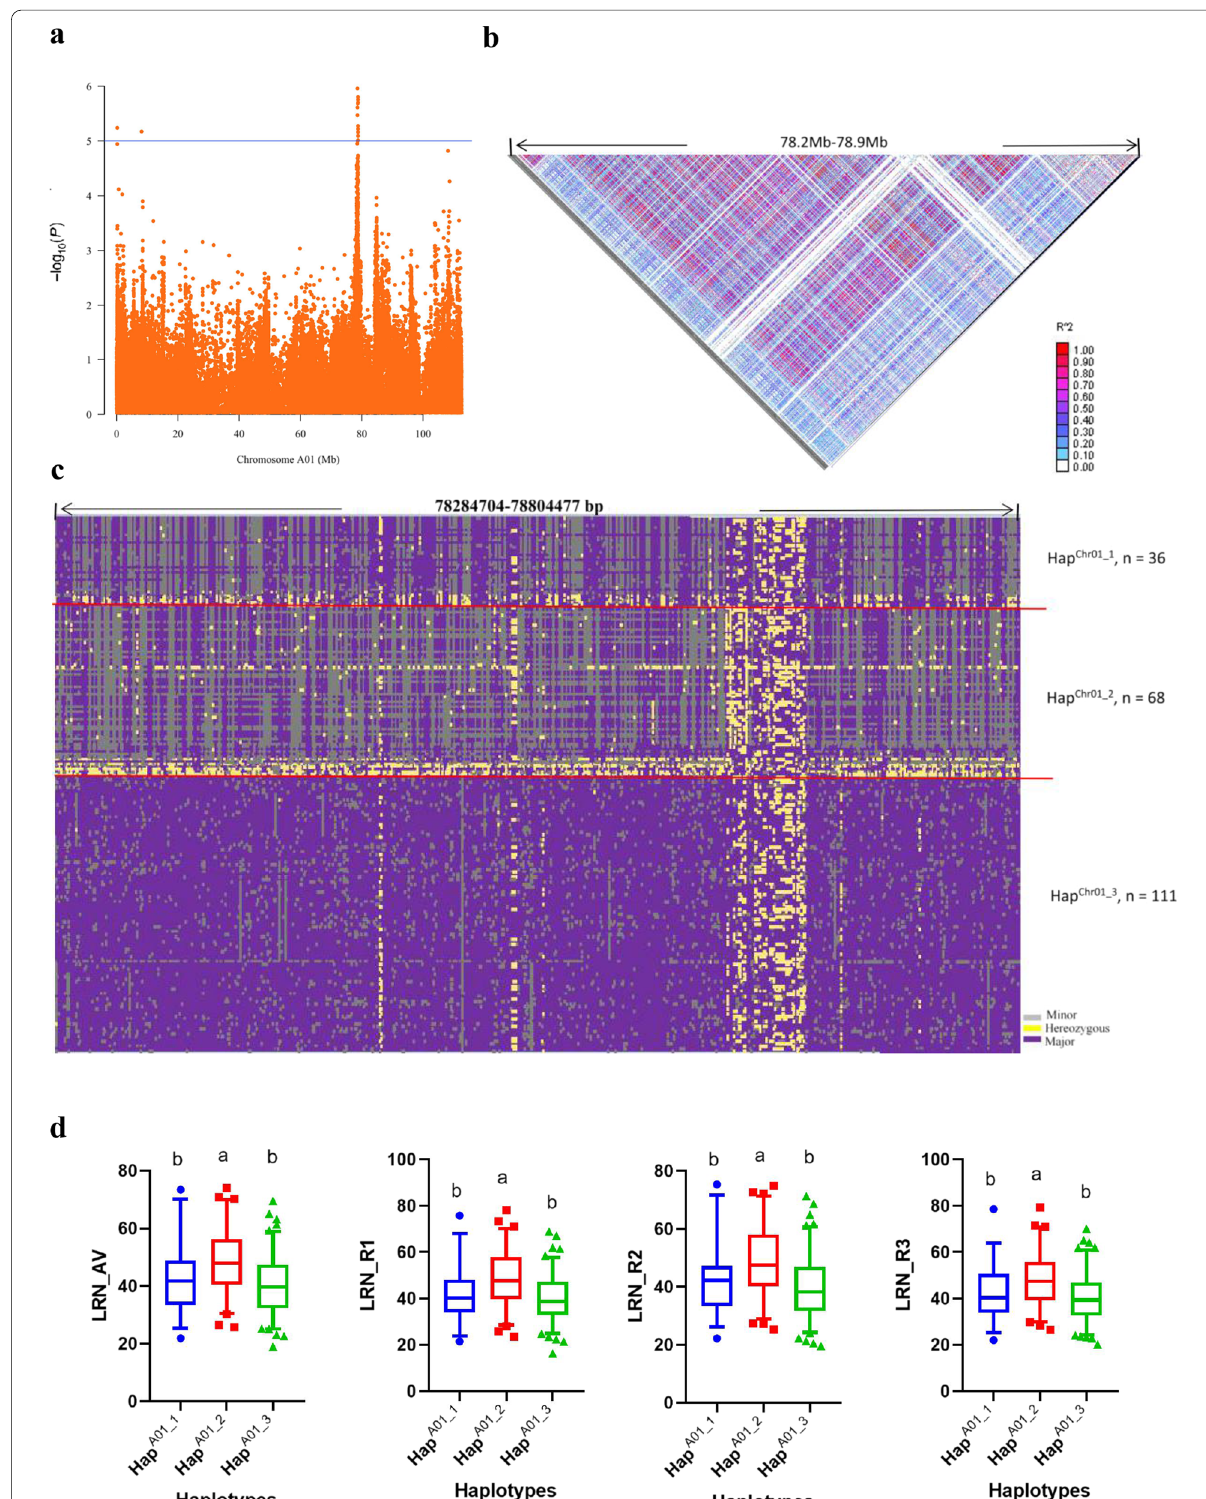
Fig. 4 Haplotype analysis of lateral root number on Chr01. a The confidence interval on Chr01. b LD block analysis. c Haplotype classification of lateral root number on Chr01:78 2847 04–788 04 477. d Comparision of lateral root number between different